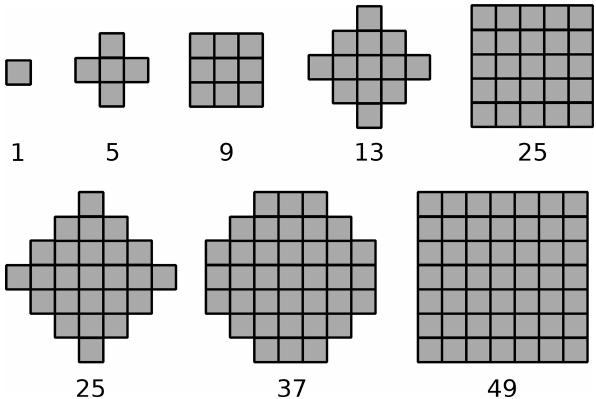
Figure 4. Examples of neighborhoods with different sizes ( n s ) used for calculating the local